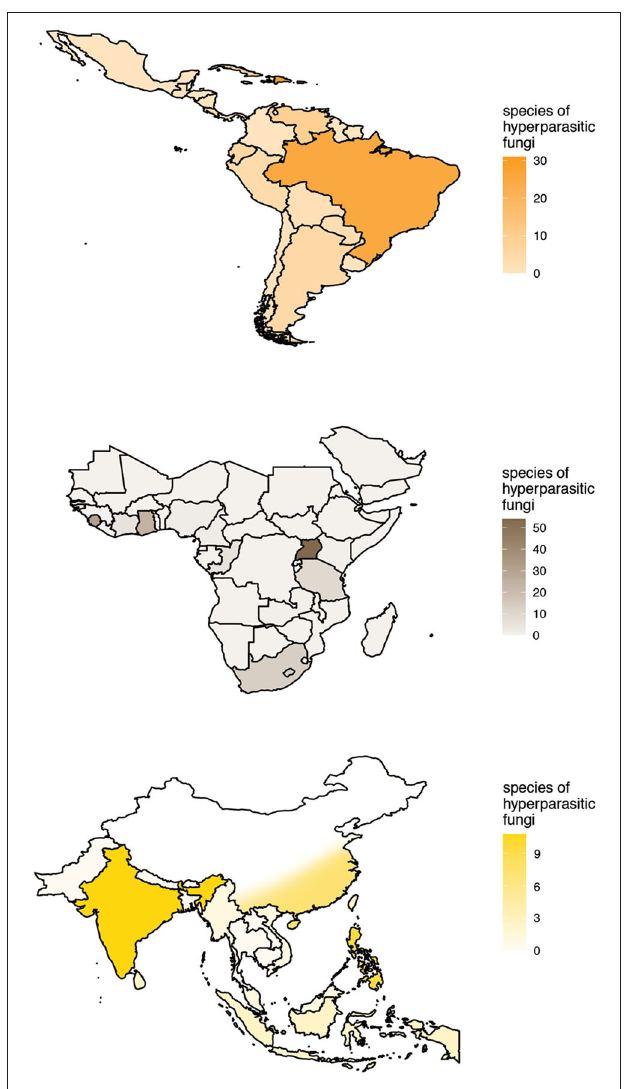
FIGURE 5 | Known species richness and geographic distribution of hyperparasitic fungi on Meliolales in the Neotropics, Afrotropics, and Indomalayan ecoregions according to checklist data. Maps with color intensities relative to the number of hyperparasitic species known per country.